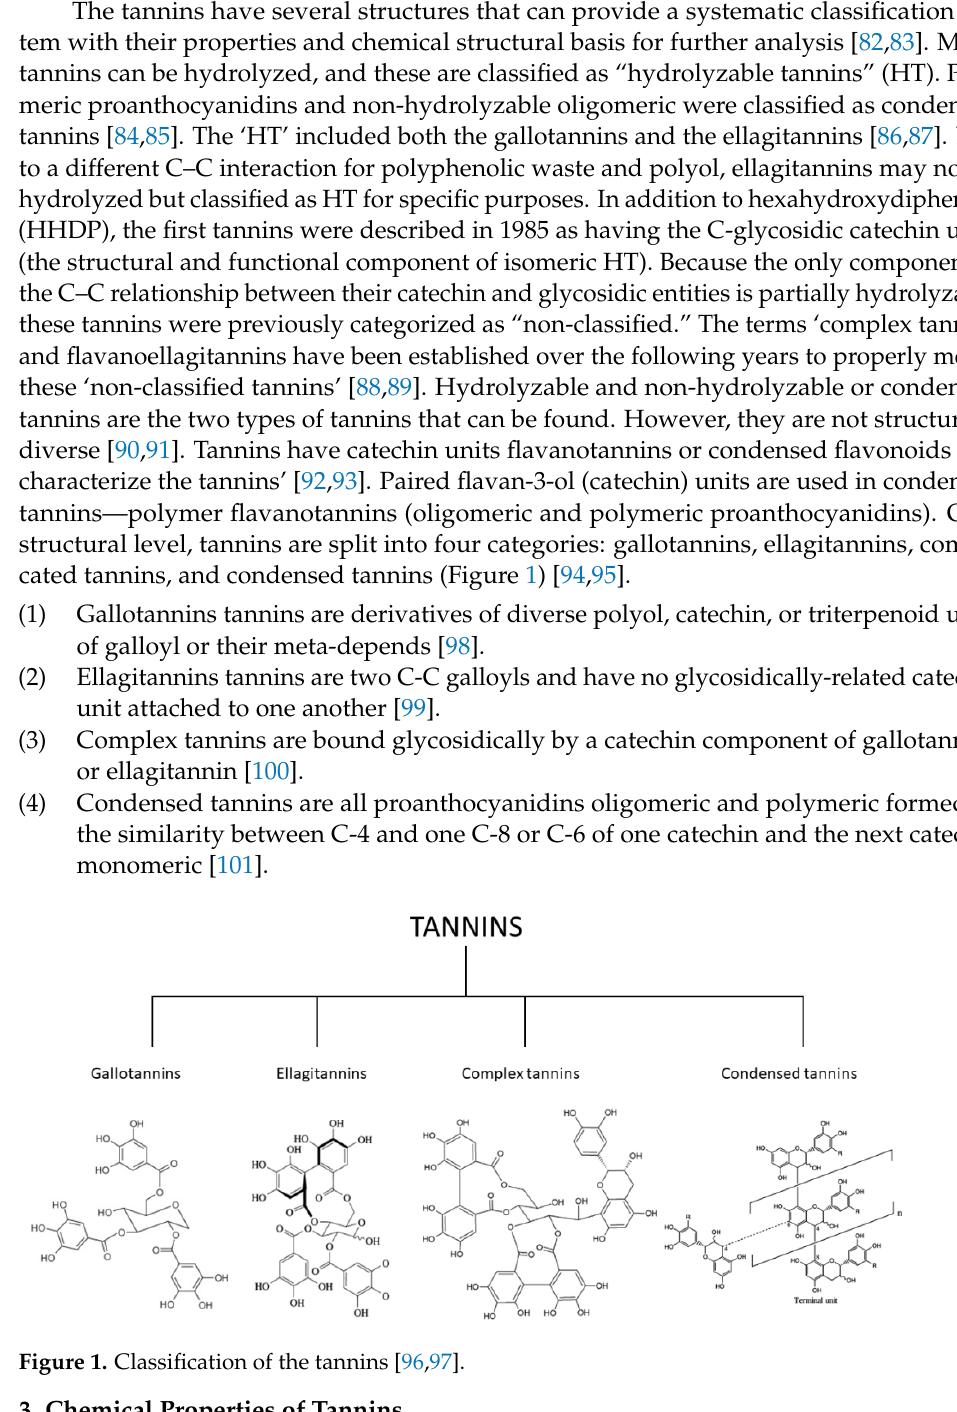
Figure 1. Classification of the tannins [96,97]